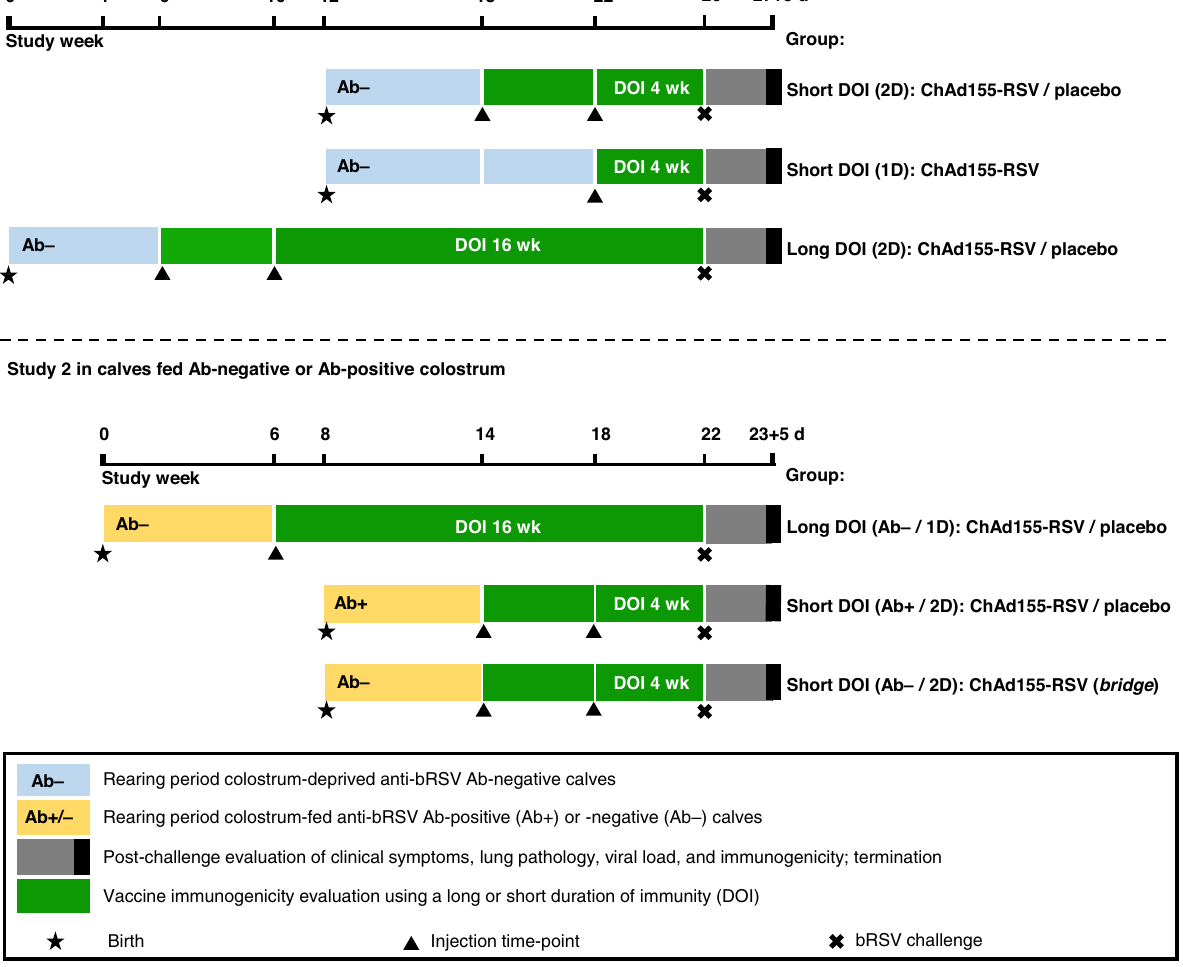
controls).Correspondingvaccineandcontrolgroupsfollowedthesametreatment/ challenge schedules after either a short (4 weeks) or a long (16 weeks) duration of immunity (short DOI or long DOI, respectively). Short or long DOI calves were recruited in two separate cohorts to arrange the challenge on the same calendar